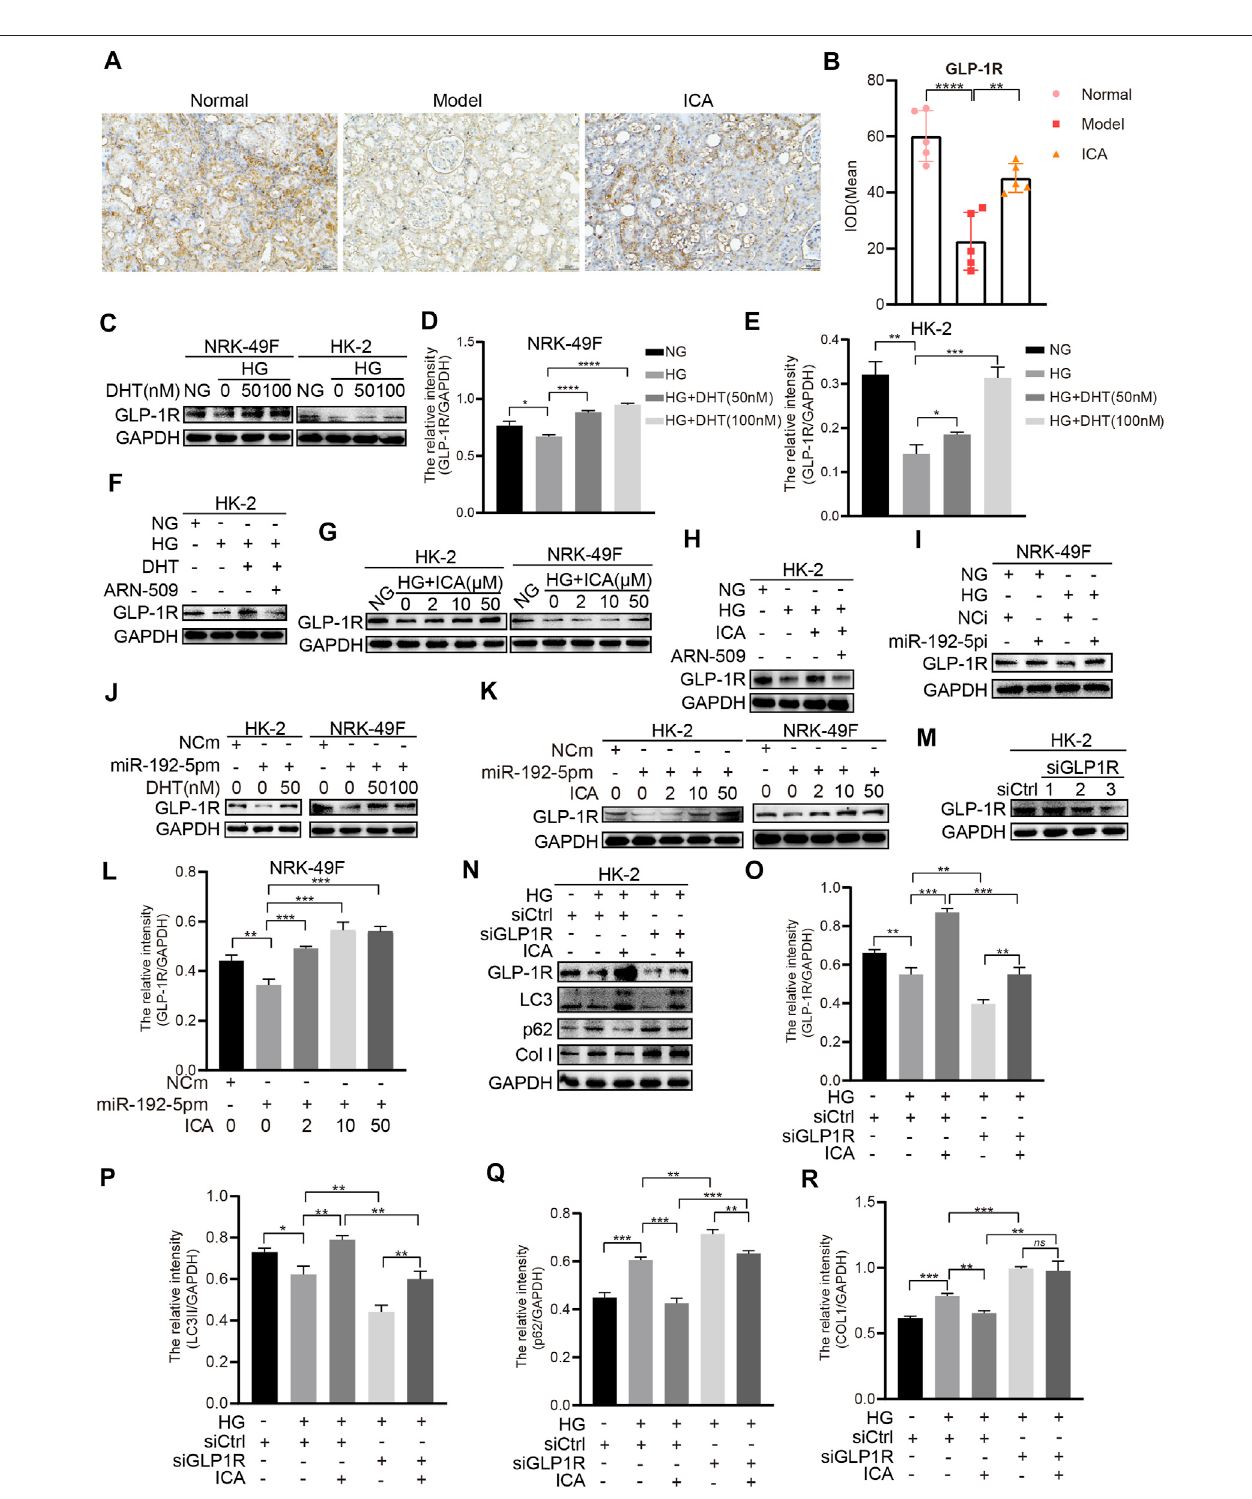
FIGURE 7 | ICA and DHT induce autophagy and reduce fi brosis through miR-192-5p/GLP-1R pathway (A) Immunohistochemical staining of GLP-1R in rats renal tissues (Scale bar: 50 μ m; original magni fi cation: × 200) (B) The mean IOD of GLP-1R expression was analyzed by IPP software. Error bars represent SD; n (cid:1) 5; ** p < 0.01,**** p < 0.0001 (C – E) HK-2andNRK-49FcellsweretreatedwithHGandDHTfor48 h,thentheexpressionofGLP-1RwasdetectedbyWesternblotandanalyzed bytheChemiScopeanalysissoftware(* p < 0.05,** p < 0.01,*** p < 0.001,**** p < 0.0001) (F) HK-2cellsweretreatedwithHG,DHTorARN-509,andtheexpression of GLP-1R was detected (G) The expression of GLP-1R in HK-2 and NRK-49F cells treated with HGand ICA (H) HK-2 cells were treated with HG (30 mM), ICA (50 μ M)